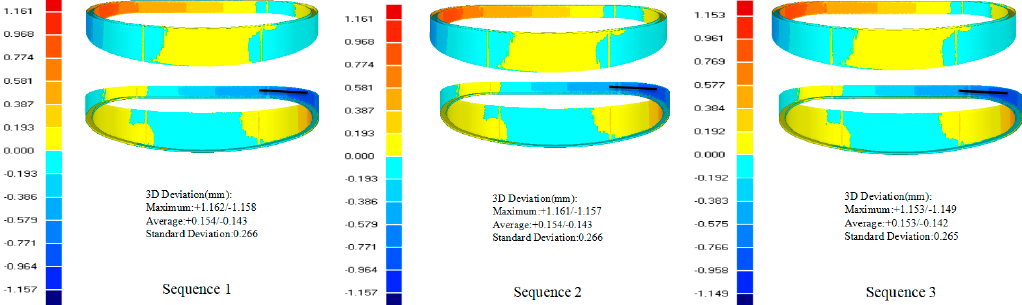
Figure 20. Colored maps of welding distortions in the three different sequence. The values on the left represent displacements, of which the positive values represent the outward distortion at outer shell and inward distortion at inner shell, and the negative values represent outward distortion at inner shell and inward distortion at outer shell. Specific routes (black lines) were chosen at the same position to analyze the effect of welding sequences on the welding stresses concretely.